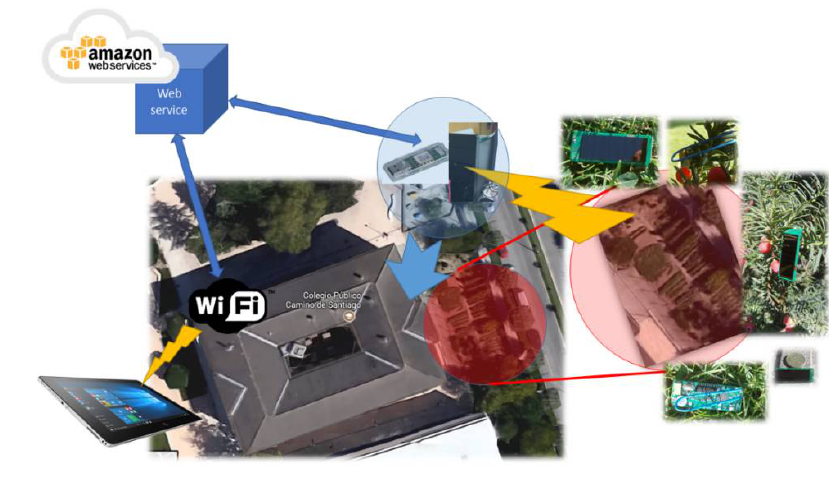
Figure 5. Shema of the system architecture.